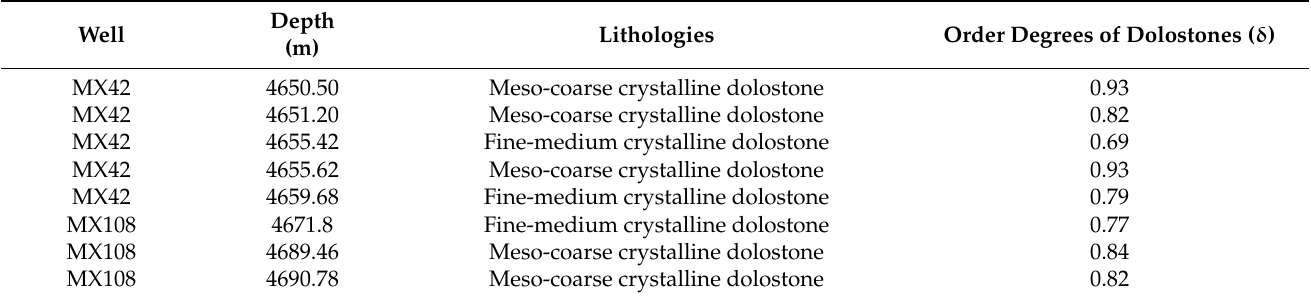
Table 2. The order degrees of various